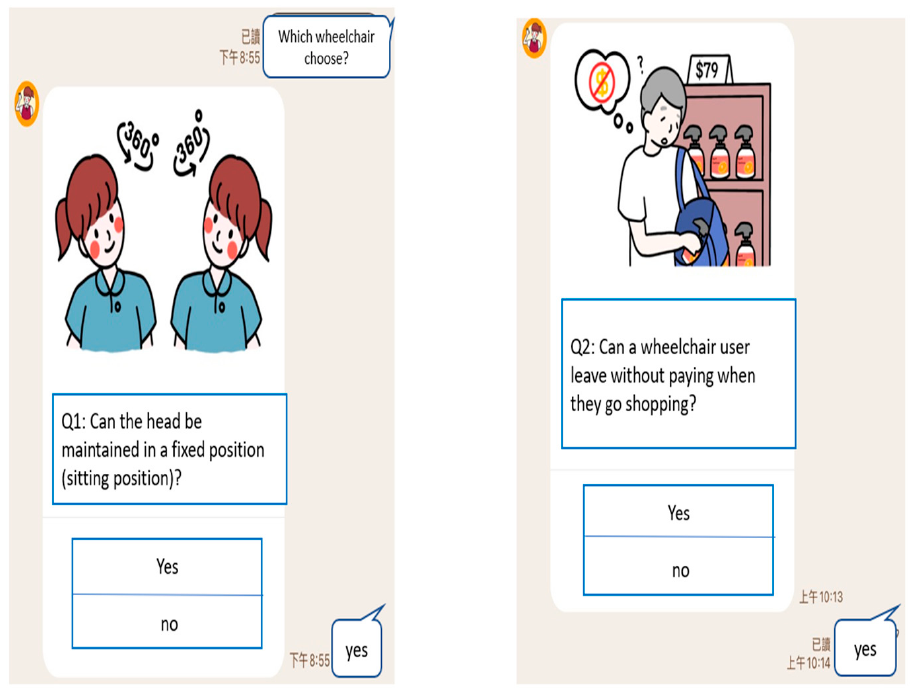
Figure 4. Assistive devices helper (LINE BOT)—question 1 ( left )/question 2 ( right ).